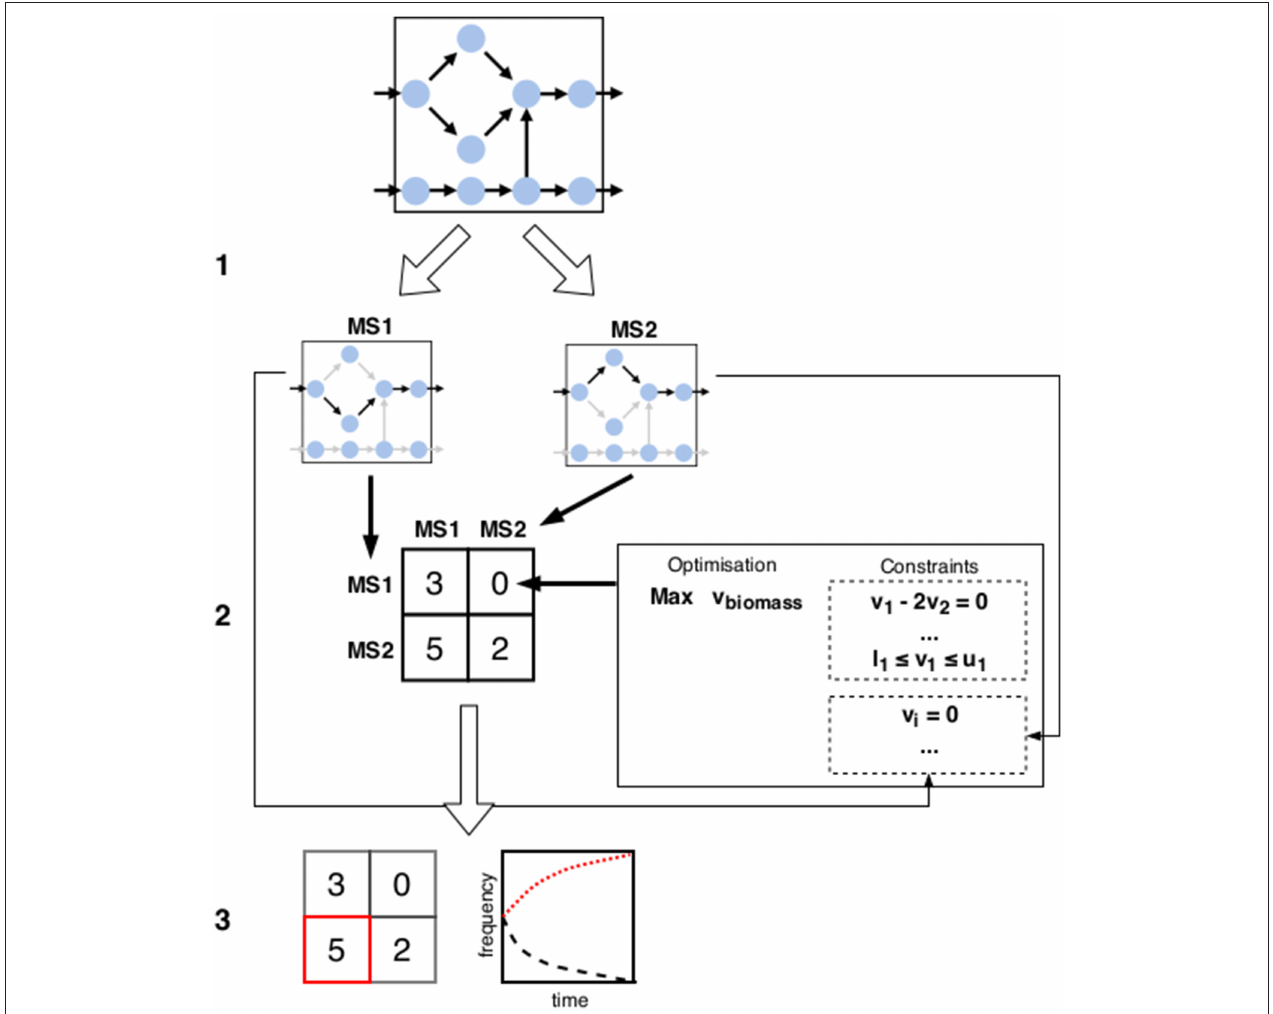
FIGURE 3 | Schematic overview of the tentative framework for metabolic games: (1) Starting from the metabolic network(s) of one or several organisms, possible metabolic phenotypes are subdivided into distinct metabolic strategies (denoted by MS1 and MS2 above). (2) Payoffs for each configuration of strategies are calculated using a method such as FBA. New constraints are added in each scenario to reflect the choice of phenotype implicated by the strategy as well as possible environmental interactions due to the strategy choices of other players (e.g., changes in substrate availability can be enforced by restricting fluxes of import reactions accordingly). (3) Predicted configuration(s) of metabolic strategies is determined by looking for the solutions of the game (e.g., finding the Nash equilibria or studying the dynamics of the